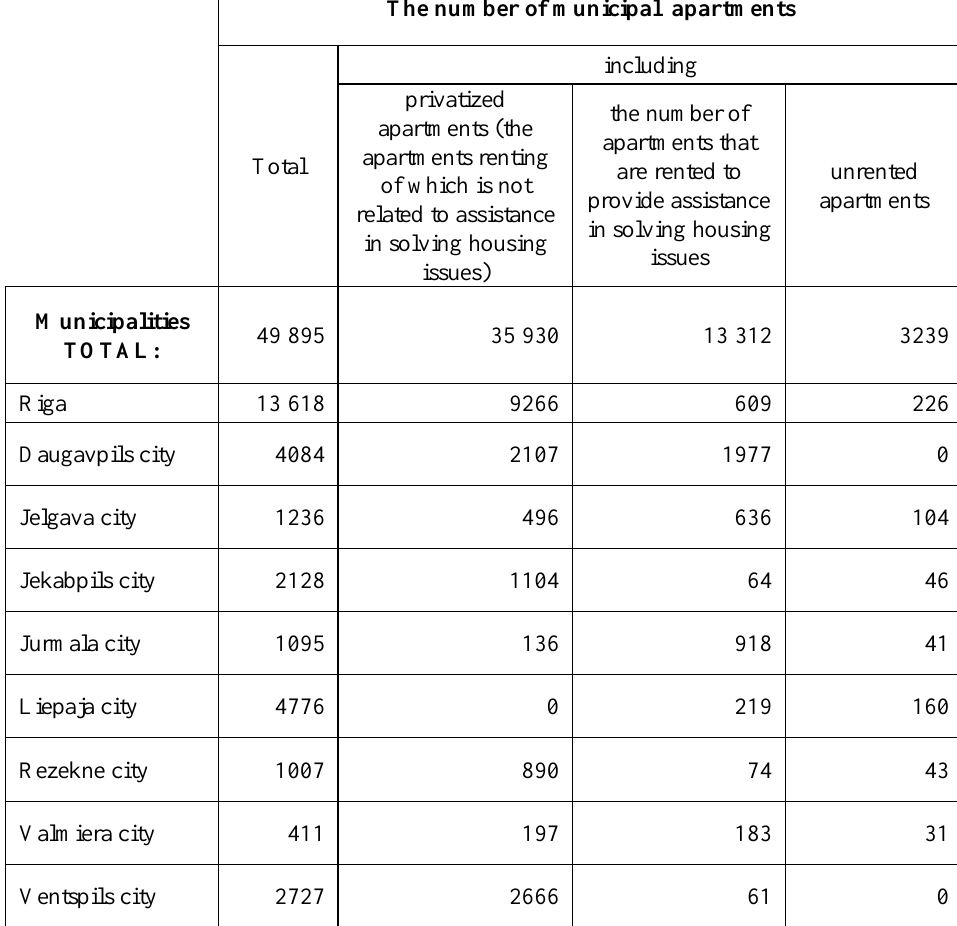
Table 1. The number of municipal apartments (Ministry of Economics of the Republic of Latvia, 2016) The number of municipal apartments including privatized the number of apartments (the apartments that apartments renting Total are rented to unrented of which is not provide assistance related to assistance in solving housing in solving housing issues issues)